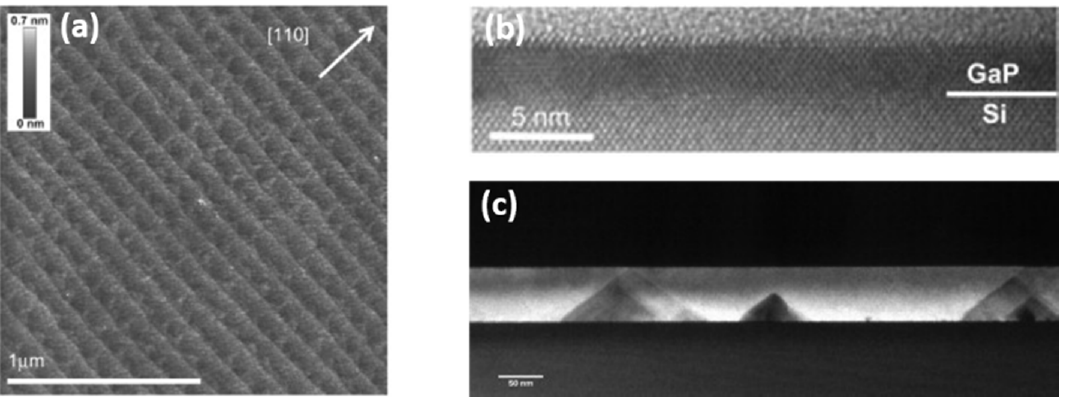
Figure 6. ( a ) AFM image of Si homoepitaxial bu ff er surface grown on (001) Si which is annealed under optimized condition (10 min, 950 mbar H 2 , 975 ◦ C); ( b ) high resolution TEM image of GaP nucleation layer on Si (nucleation temperature of 450 ◦ C, flow-rate modulated epitaxy (FME) method, and P-started nucleation). ( c ) Cross-sectional TEM dark field image of GaP layer continuously grown at 625 ◦ C with an optimized GaP nucleation layer. Reprinted with permission from Reference [126] © 2010 Elsevier